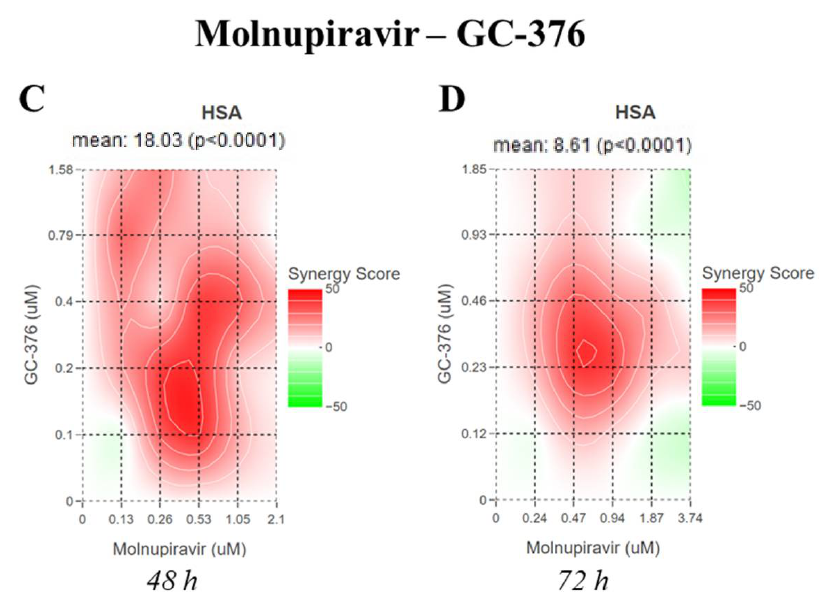
Figure 2. Synergy distribution in pairwise combination of antivirals. Vero E6 cell viability was determined after SARS-CoV-2 20A.EU1 strain infection and treatment with molnupiravir–nirmatrelvir combinations for ( A ) 48 and ( B ) 72 h, or the combinations of molnupiravir-GC376 for ( C ) 48 and ( D ) 72 h. Rescue of virus-mediated viability reduction was used for the analysis with the SynergyFinder version 2 tool. Data are from 3 independent experiments performed in triplicate. On the other hand, molnupiravir and GC-376 showed a synergistic activity only at 48 h with an HSA score of 19.33 ( p < 0.0001) and the interaction was additive at 72 h with an HSA score of 8.61 ( p < 0.0001) (Figure 2C,D).